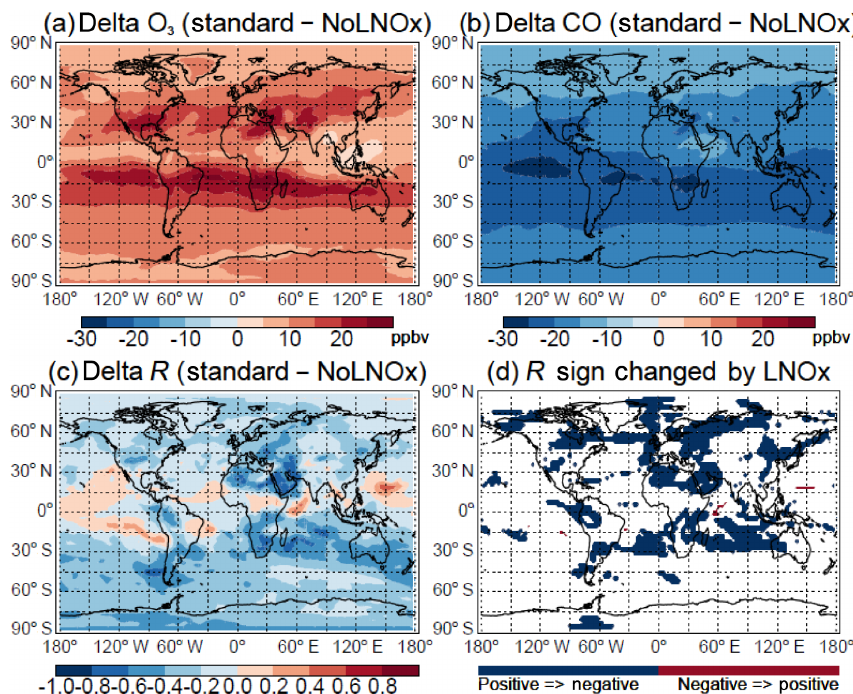
Figure 19. Same as Fig. 16 but for the sensitivity of O 3 , CO, and their correlations at 618hPa to lightning NO x (LNO x ) emissions.